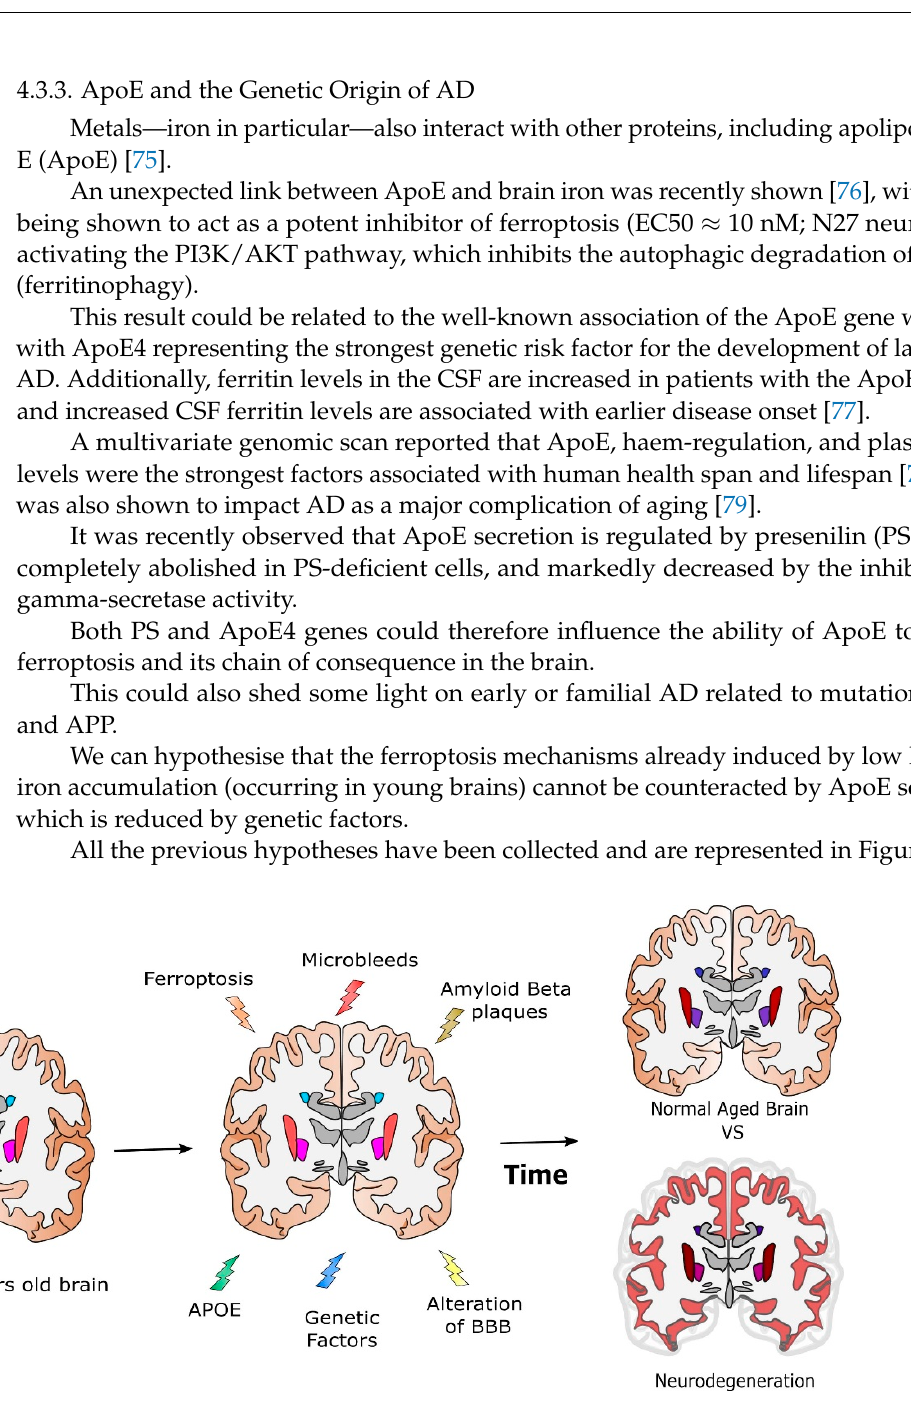
Figure 3. Potential mechanisms involved in the modulation of the brain iron concentration during aging compared with those leading to neurodegeneration and AD. Differences in brain areas are already present in normal brains, but genetic factors, ferroptosis, microbleeds, and other alterations can shift the iron content values from what is expected in a normal aged brain to larger values (darker colours), predicting neurodegeneration.